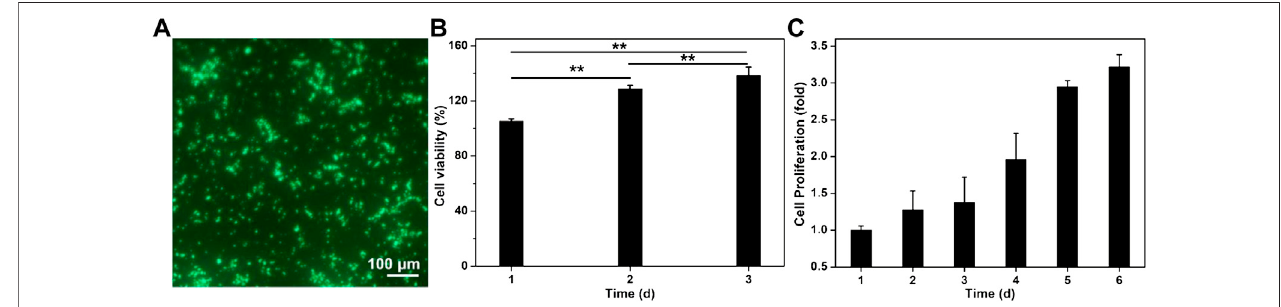
Frontiers in Pharmacology |